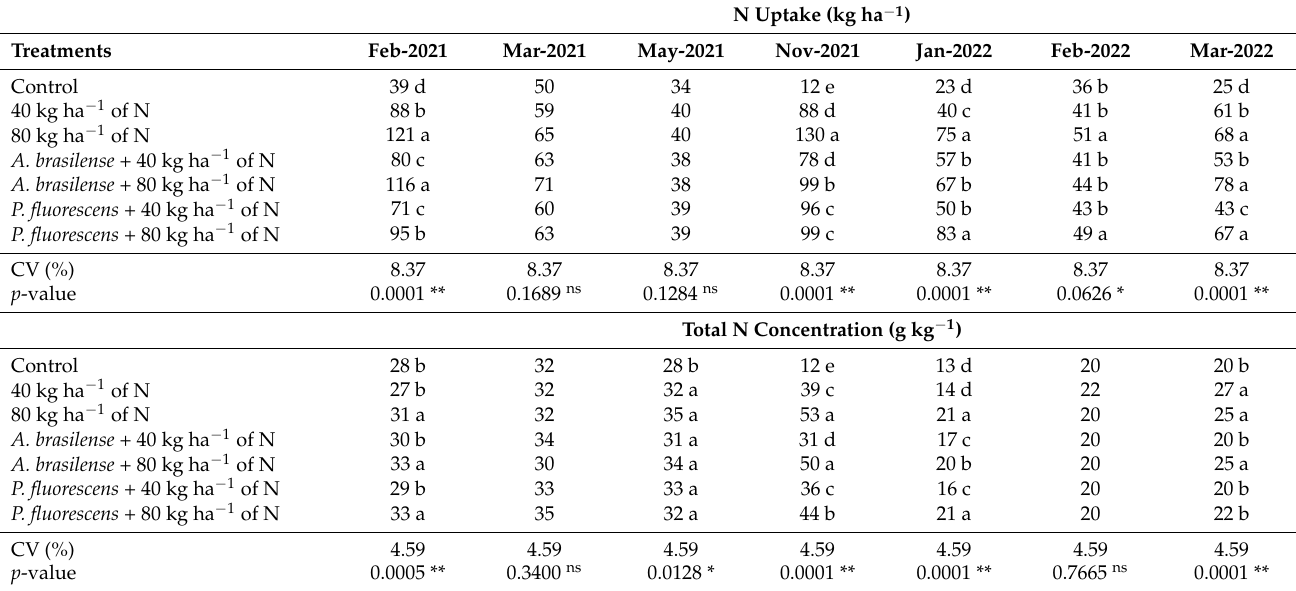
Table 5. Means of nitrogen uptake and total nitrogen concentration in the shoots of the grass Megathyrsus maximus cv. BRS Zuri inoculated with